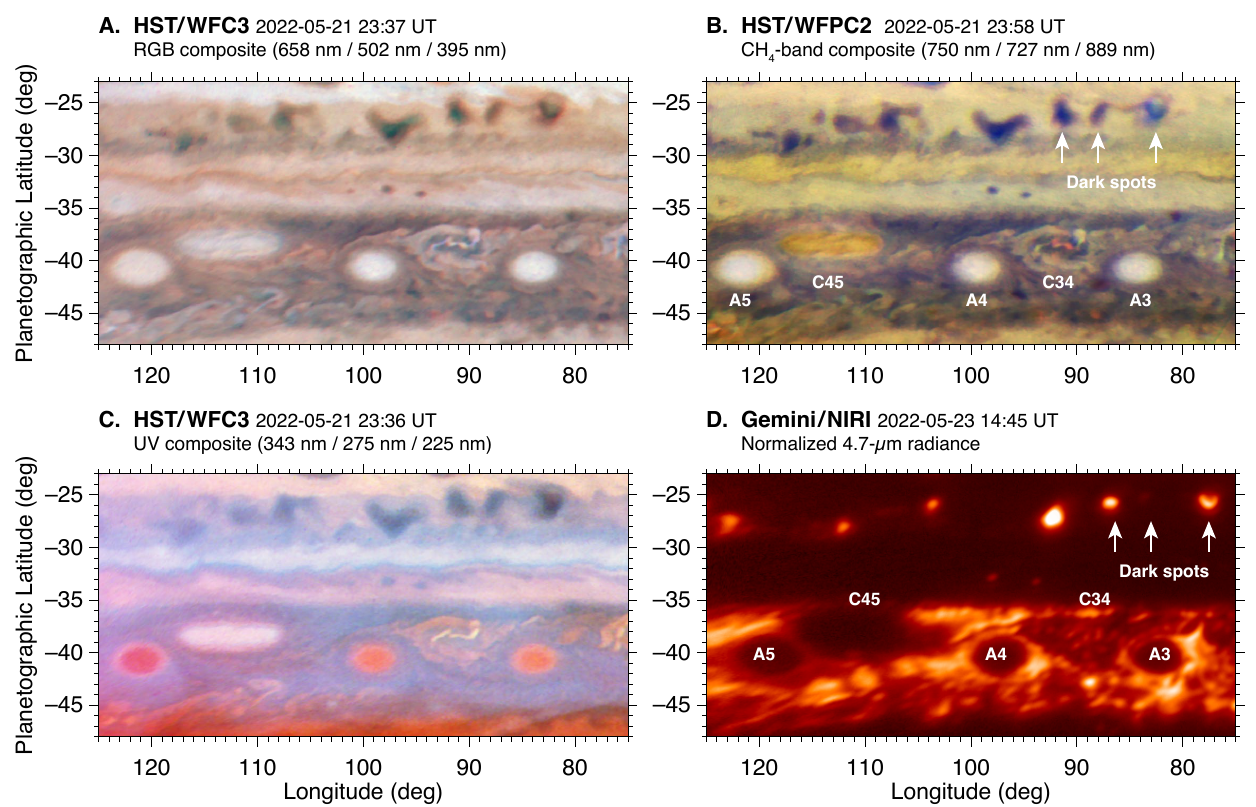
Figure 6. Two cyclonic vortices are seen in different states: C45 in a cloudy oval state appears to be non-convective, while C34 in an FFR state appears to be undergoing moist convective activity. The cyclones are numbered based on their locations between anticyclonic white ovals A3, A4, and A5, as identified by Rogers and Mizumoto [70]. ( A ) In RGB color, cloudy oval cyclone C45 appears white. ( B ) The CH 4 -band composite shows a diversity of cloud opacities and depths within C34. High-altitude haze (picked up in the 889-nm channel) is depleted. ( C ) The white appearance of C45 in the UV composite is another effect of depleted upper-tropospheric haze. ( D ) The infrared map is speckled with small clearings within C34, while in C45, a thick layer of upper-level cloud opacity uniformly attenuates outgoing thermal radiation. The central dark spot from panel C is invisible in panel D, suggesting evolution over the two days separating the HST and Gemini